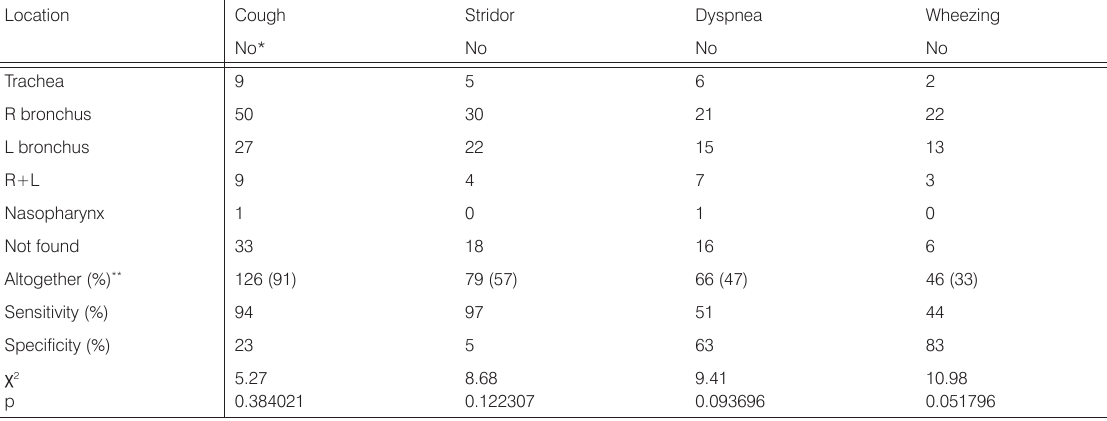
Table 1. Most frequent clinical symptoms of suspected FBA according to location